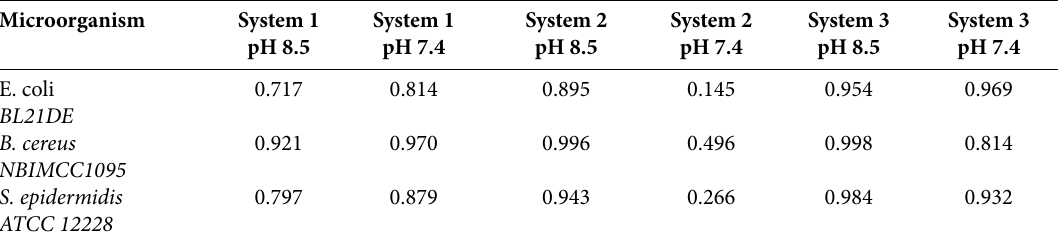
Table 3. Correlation coefficients between the sensitivity of chosen bacterial strains toward the antimicrobial effect of ZnO, ZnO NCs, ZnO-SiO A , and ZnO-SiO B NMs tested by spot diffusion and chemiluminescent